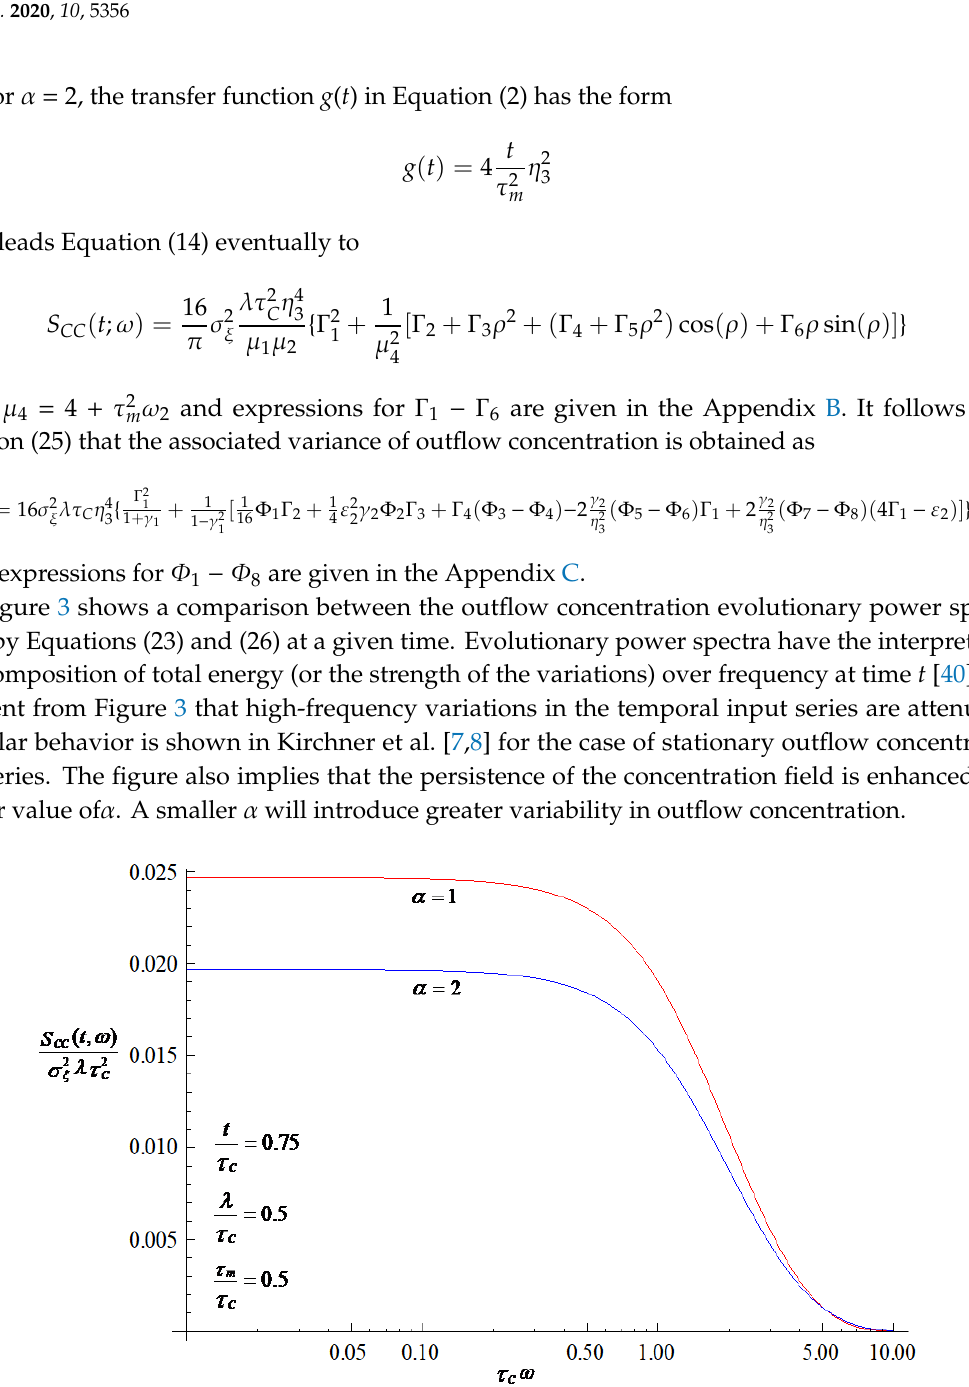
Figure 3. Comparison between the dimensionless evolutionary power spectra for the outflow concentration processes in Equations (23) and (26) at a given dimensionless time.